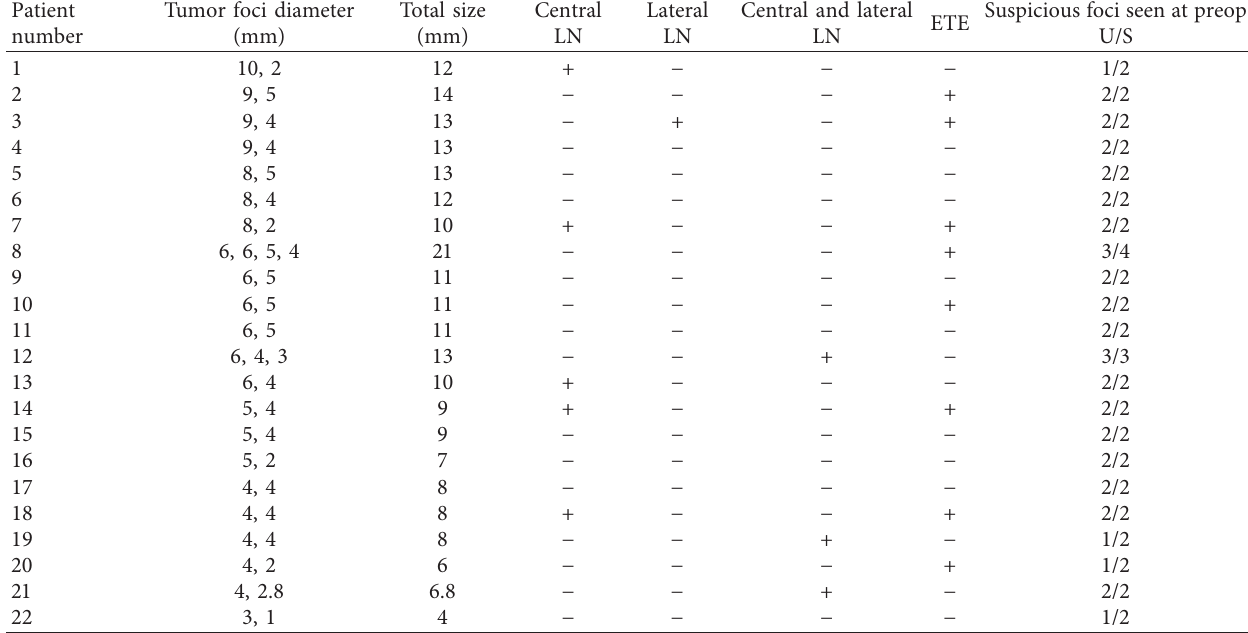
Table 3: Patients with multifocal disease.